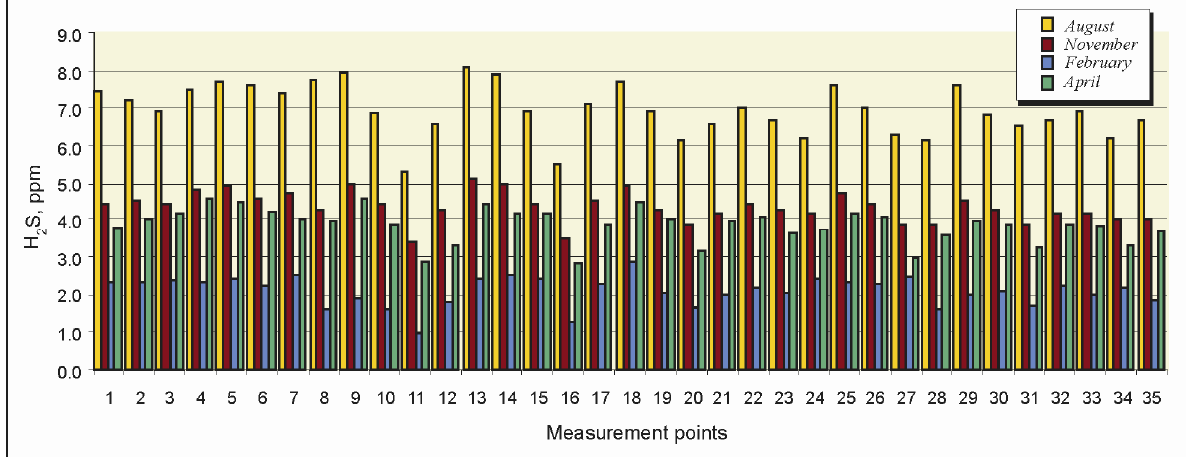
Fig. 4. Identified H 2 S values in Jerubaičiai landfill well No.